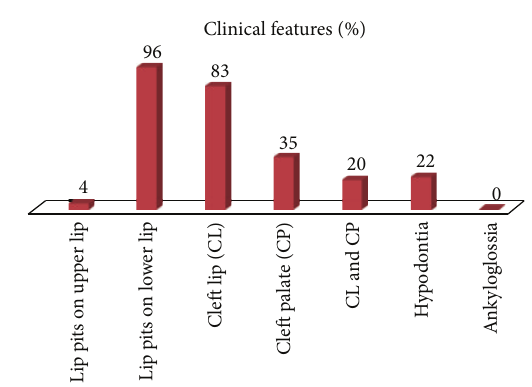
Figure 7: Showing the clinical features noted in all of the cases of VWS reviewed by the